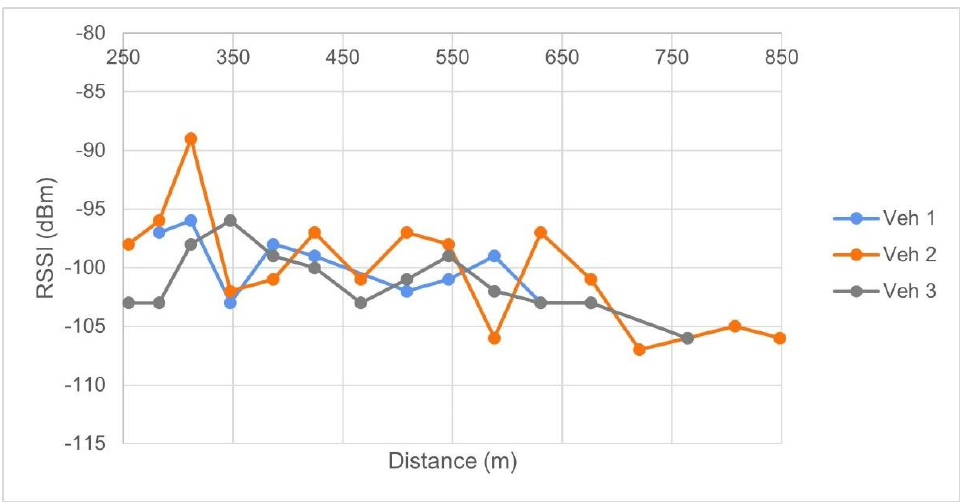
Figure 15. RSSI values obtained for Experiment 5, in the setting SF = 9, BW = 250 kHz and CR = 4/5.